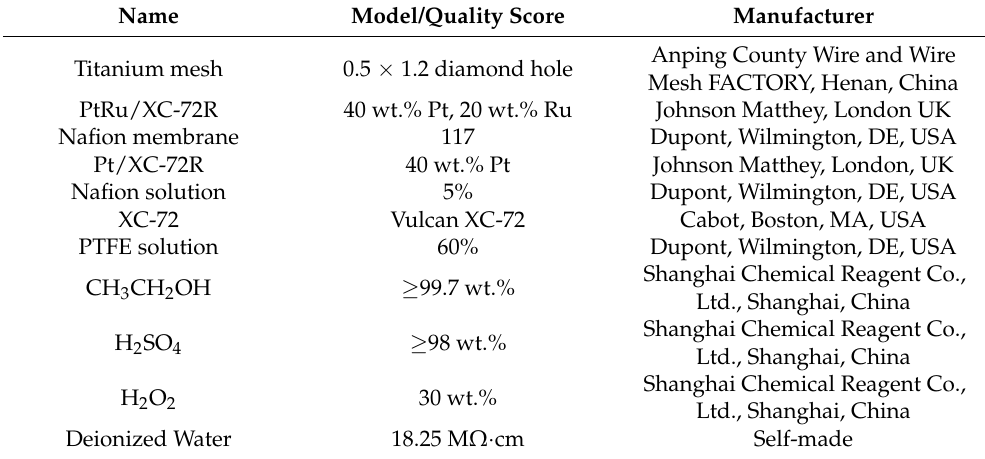
Table 1. Experimental materials.